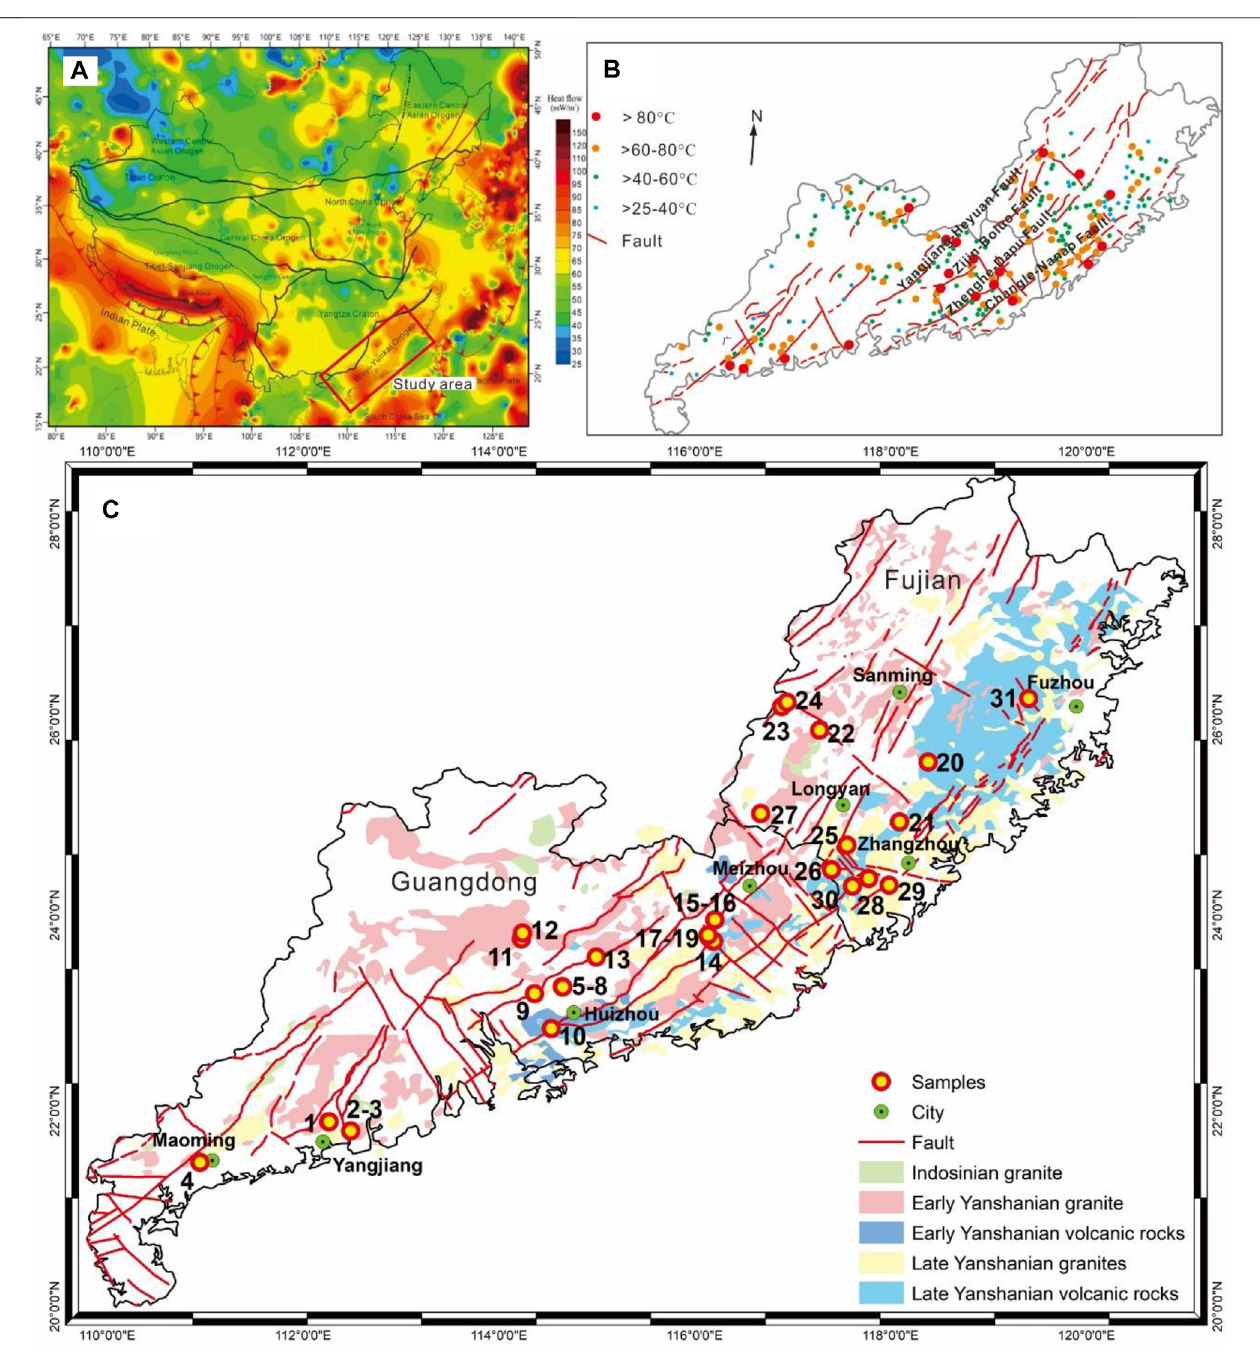
Table 1 . For the samples located tightly in the study area, they are labeled as a range, for example, “ 5 – 8 ” represents sample number range from 5 to 8).